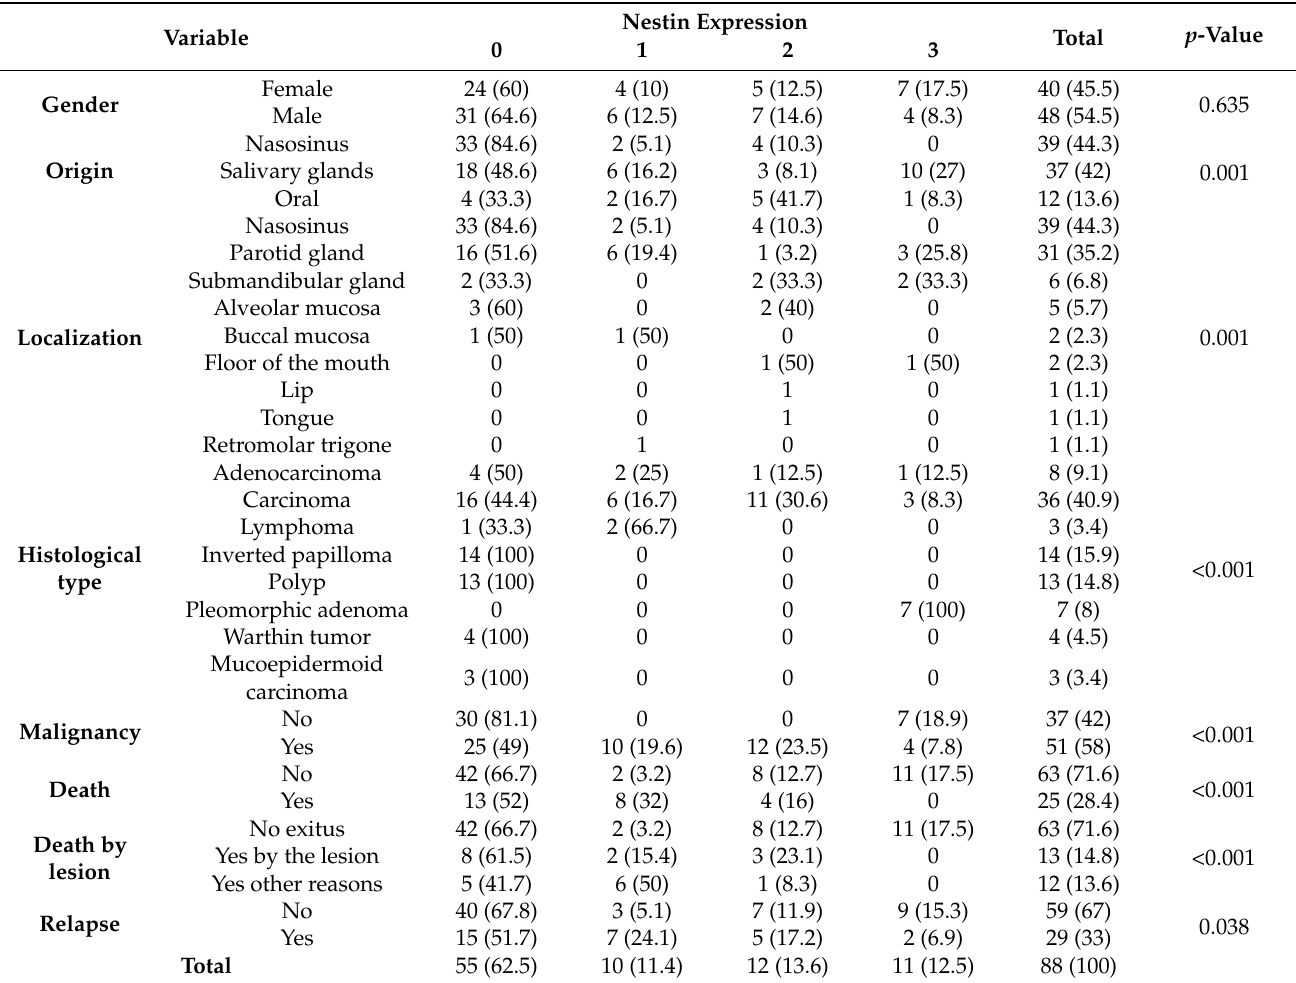
Table 1. Distribution of categorical variables by Nestin expression analyzed through Kruskal–Wallis